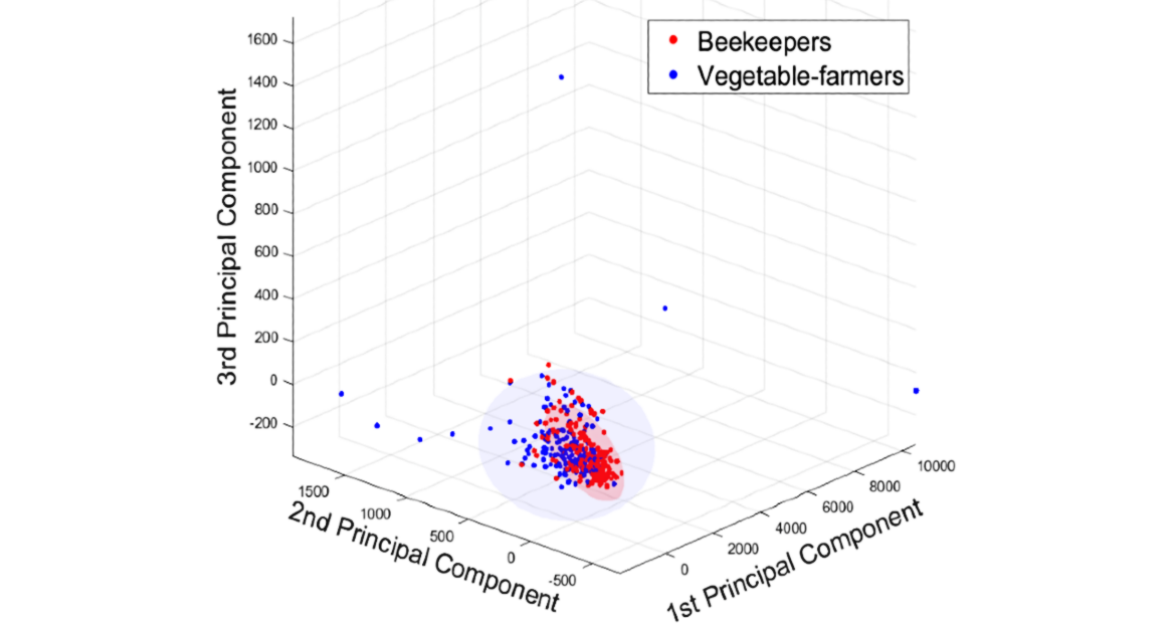
Figure 2. The first 3 principal components of blood index result, using PCA to compare between beekeepers group and vegetable-farmers group, sampled from Wuhan, China, between February and April 2016. Shaded areas represent two standard deviations of each